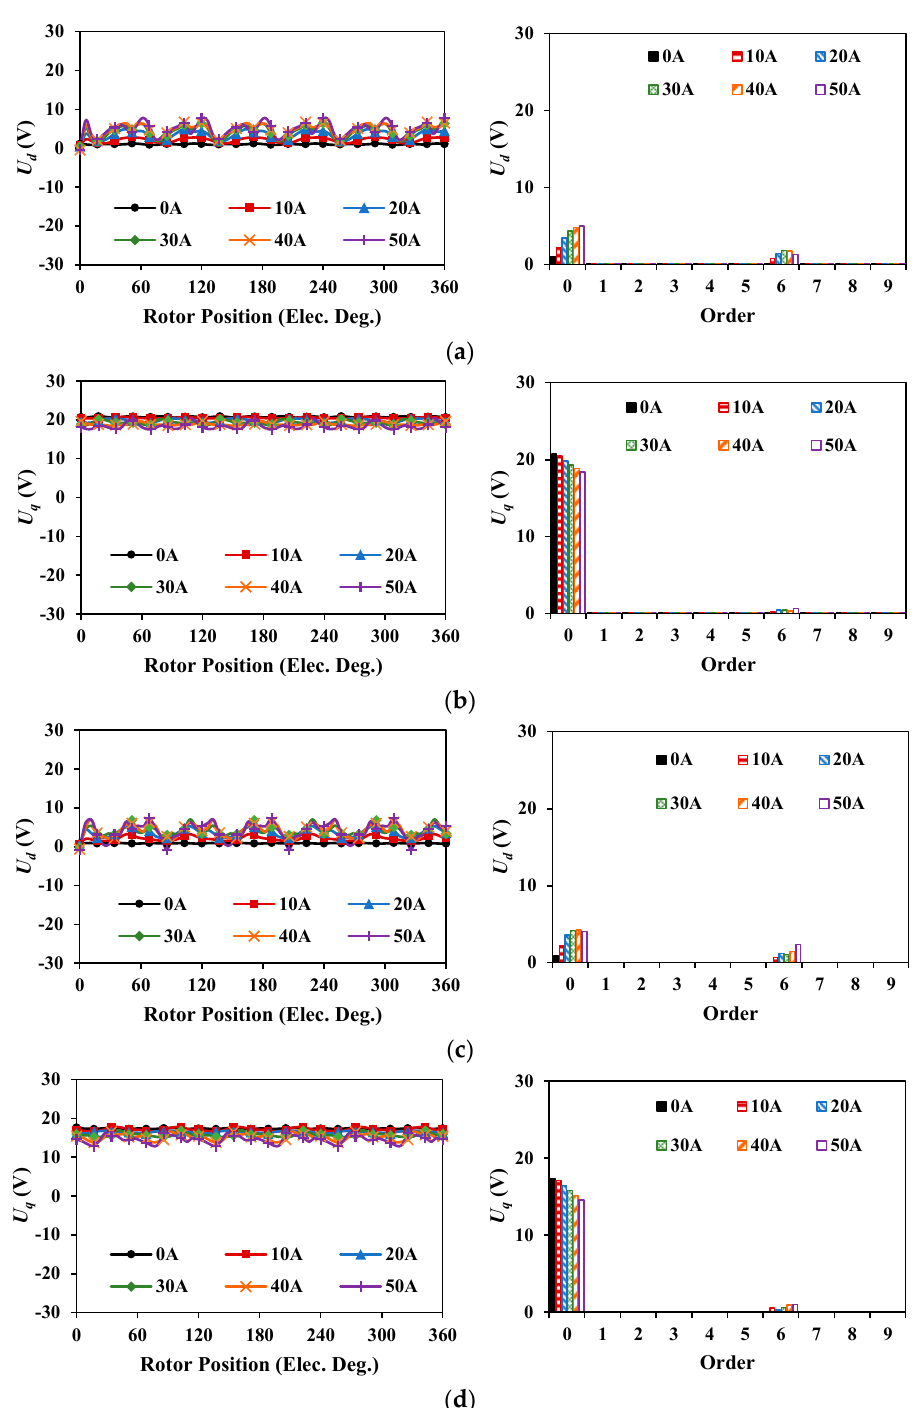
Figure 15. Back-EMFs and spectra for 12s10p machines. ( a ) D-axis back-EMF of 12s10p-SPM. ( b ) Q-axis back-EMF of 12s10p-SPM. ( c ) D-axis back-EMF of 12s10p-CCPPM. ( d ) Q-axis back-EMF of 12s10p-CCPPM.